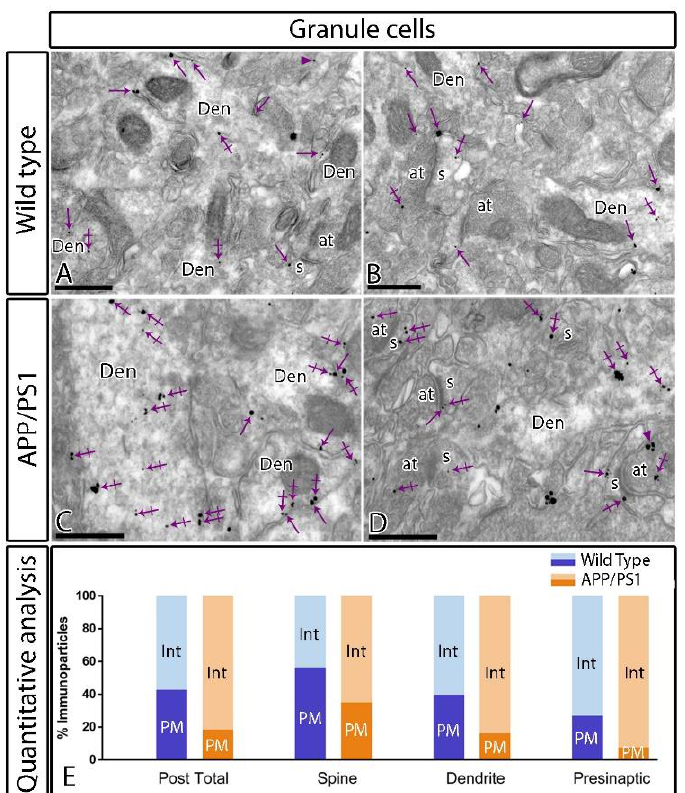
Figure 6. Intracellular distribution of GABA B1 is increased in the DG of APP / PS1 mice. Electron micrographs showing immunoparticles for GABA B1 in granule cells of the inner molecular layer of the DG at 12 months of age in wild type and APP / PS1 mice, as detected using a pre-embedding immunogold technique. ( A – D ) Both in wild type and APP / PS1 mice, GABA B1 immunoparticles were found along the extrasynaptic plasma membrane (arrows) and intracellular sites (crossed arrows) of dendritic shafts (Den) and spines (s) of granule cells contacted by axon terminals (at), and less frequently at presynaptic sites (arrowheads). ( E ) Quantitative analysis showed that immunoparticles for GABA B1 were less frequently observed along the extrasynaptic plasma membrane dendrites and spines of granule cells in APP / PS1 mice, as well at presynaptic sites, but, instead, they were more frequently detected at intracellular sites. Scale bars: A – D , 0.4 µ